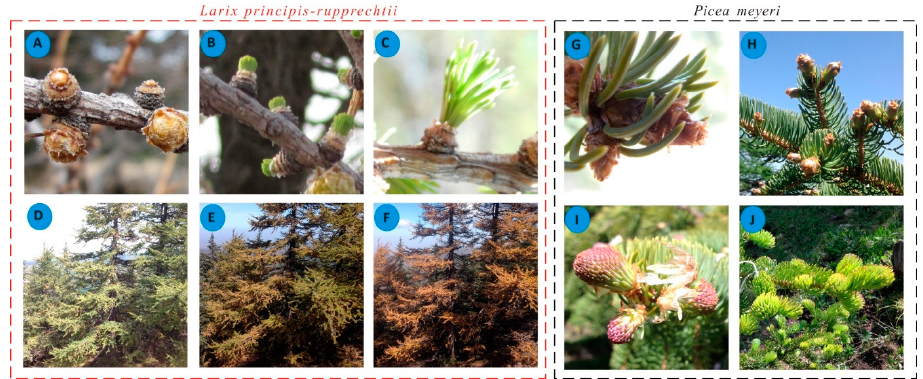
Figure 3. Illustrations of some stages of primary growth in Larix principis-rupprechtii ( A – F ) and Picea meyeri ( G – J ). A : unexpanded bud (18 April); B : bud burst (5 May); C : needles unfolding (16 May); D and E : leaf senescence (18 September and 25 September, respectively); F : defoliation (2 October) for larch; G : bud burst (25 May); H : new shoot elongation (18 April); I : needles unfolding (2 June); J : new shoot growth (21 June) for spruce.